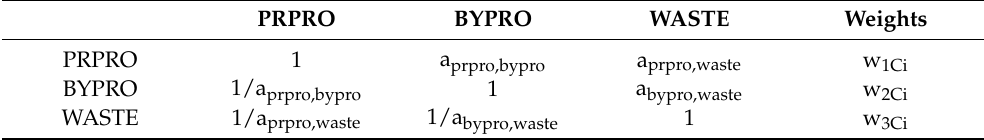
Table 7. Pair-wise comparison matrix of the options with respect to criterion Ci. PRPRO BYPRO WASTE Weights PRPRO 1 a prpro,bypro a prpro,waste w 1Ci BYPRO 1/a prpro,bypro 1 a bypro,waste w 2Ci WASTE 1/a prpro,waste 1/a bypro,waste 1 w 3Ci Each weight (w yCi ) is multiplied by the global weight (gw i ) of the respective criterion and summed to the score for each option (Equation